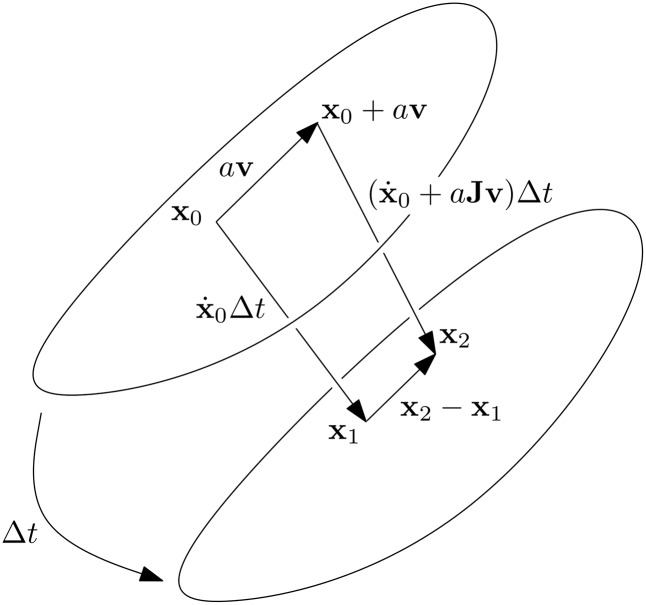
Perturbed solutions and their behaviour.These particular solutions are shown to converge as time is perturbed forward. The N–dimensional state space is represented conceptually as a surface and time as an arrow.